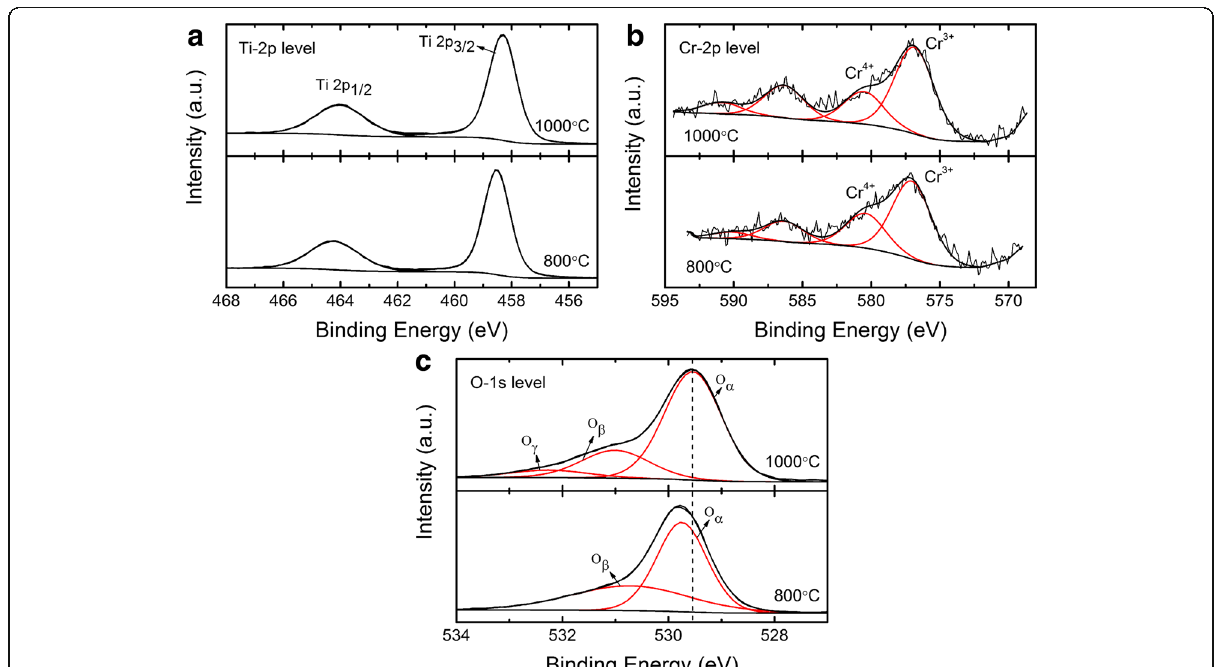
Fig. 3 XPS spectra of the a Ti-2 p , b Cr-2 p , and c O-1 s level in Ti 1 − x Cr x O 2 samples ( x =